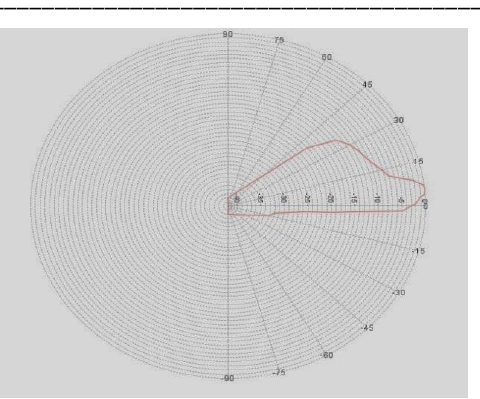
Fig. 3. Cosecant square antenna pattern used in SEAMCAT (vertical pattern).